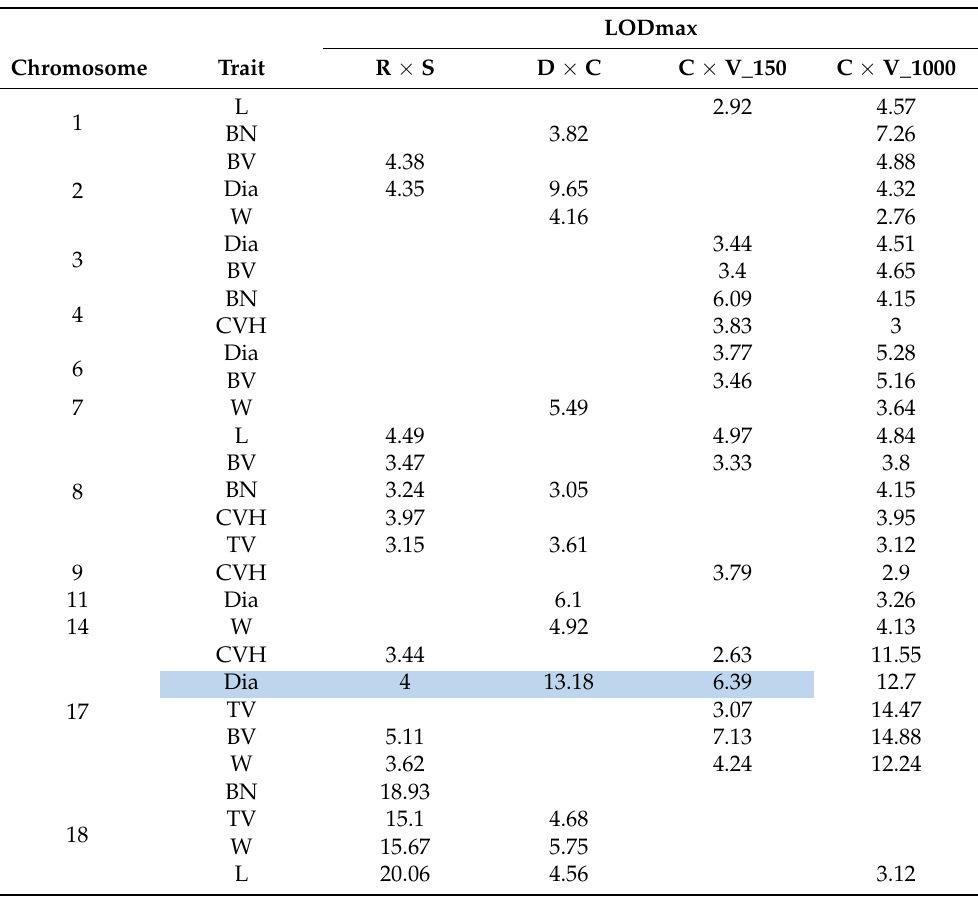
Table 2. Overview of QTLs derived from the investigated populations. Shown are only QTLs with their respective LODmax values, occurring in at least two populations and located on the same chromosomes. QTLs occurring in all investigated populations on the same chromosome are highlighted (light blue background). Note that the QTLs listed for C × V _1000 are considered as preliminary QTLs, as they are based on one-year data only. Berry number = BN, berry diameter = Dia, berry volume = BV, total volume = TV, convex hull volume = CVH, bunch width = W, and bunch length = L. LODmax Chromosome Trait R × S D × C C × V_150 C ×